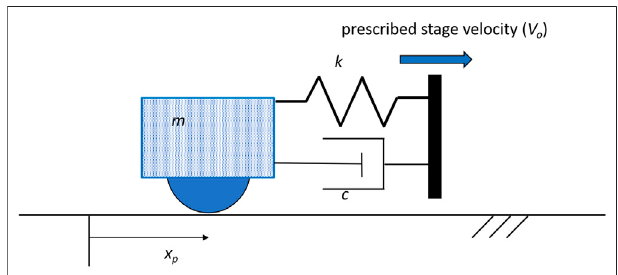
FIGURE 4 | Con fi guration of system considered in dynamic